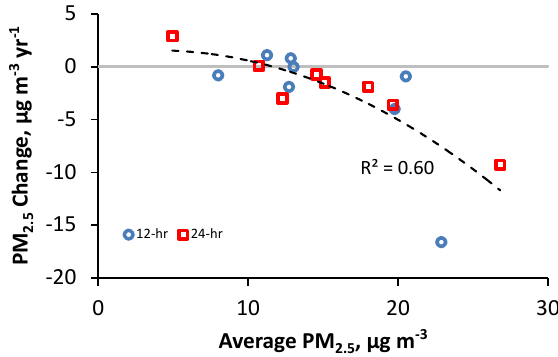
Figure 13. Weighted trend of PM 2 . 5 mass by 12 and 24h trajectory